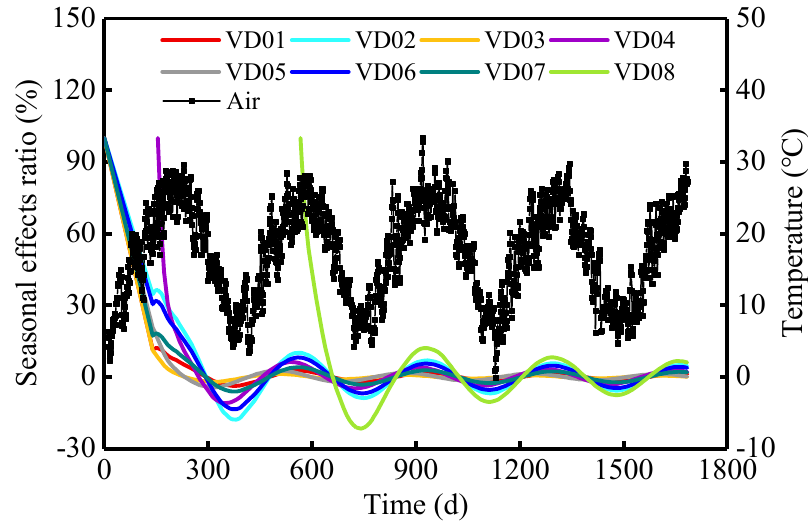
Figure 8. Fluctuations of the ratio of seasonal effects to the total RVCs.